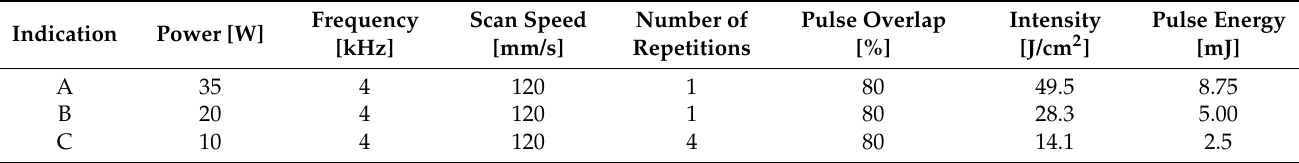
Table 2. Laser parameters used to create